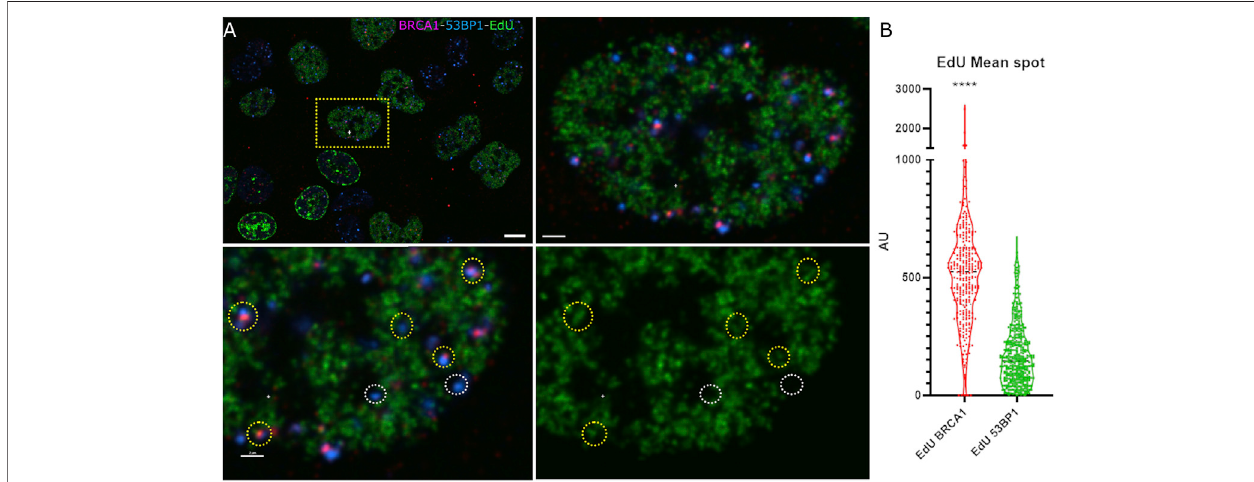
FIGURE 3 | 53BP1-rich foci are found in association with newly replicated chromatin in early S phase. (A) U2OS cells pulse labeled with EdU and irradiated were examinedfornewlyreplicatedchromatindistribution(EdU,green),53BP1(blue),andBRCA1(red).AnearlyS-phasecellishighlightedintheupperleftpanelshowingthe fi eldoflabeledcells.Thetoprightpanelshowsahighermagni fi cationviewofthesamecell.Thebottomtwopanelsshowasubregionofthisnucleuswith(left)andwithout (right) the 53BP1 and BRCA1 channels. The yellow circles highlight chromatin that is positive for 53BP1. These same foci show varying amounts of BRCA1. The whitecircles highlight 53BP1 foci thatclearly reside in regions thathave notbeen replicated. (B) Violin plot showing theEdU mean intensity in BRCA1 versus 53BP1 foci in early S-phase cells where EdU is indicative of DNA replication. Quanti fi cation of EdU BRCA1 mean intensity versus EdU 53BP1 mean intensity, **** p ≤ 0.0001. The scale bar represents 2